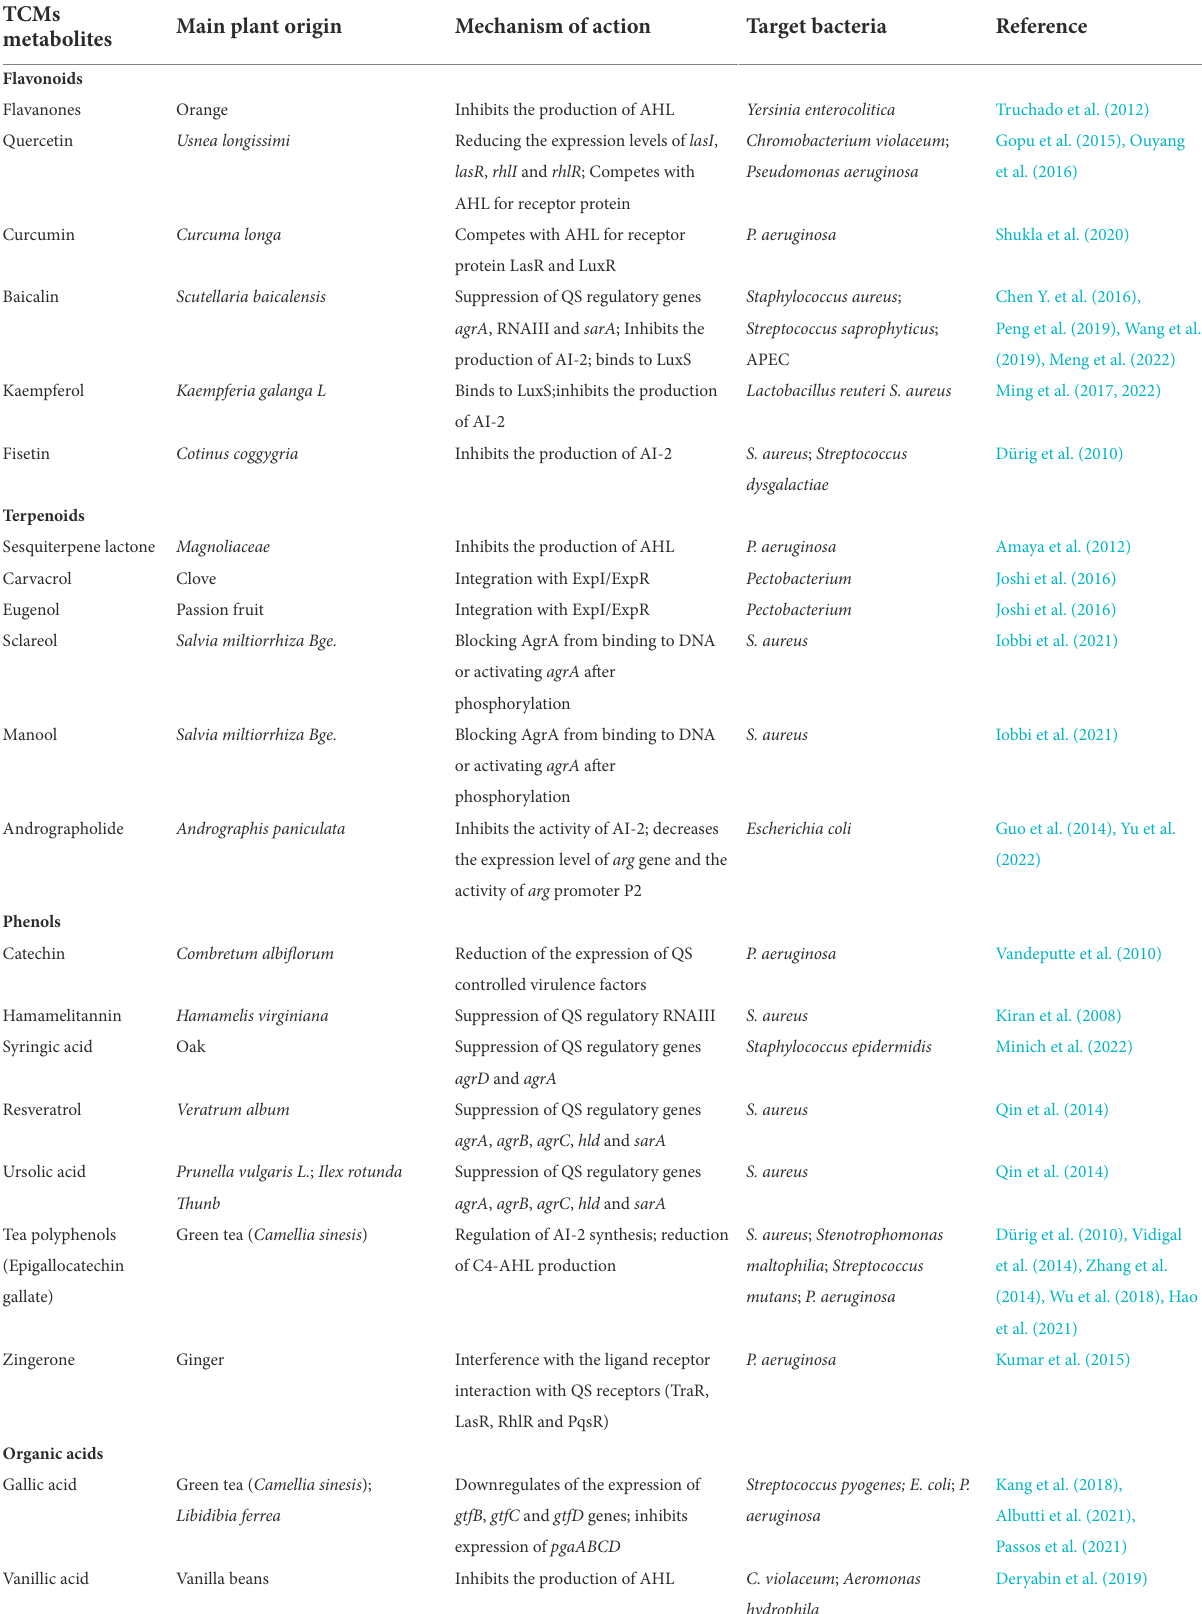
TABLE 1 Different classes of anti-biofilm TCMs metabolites and their mechanisms of action via bacterial QS